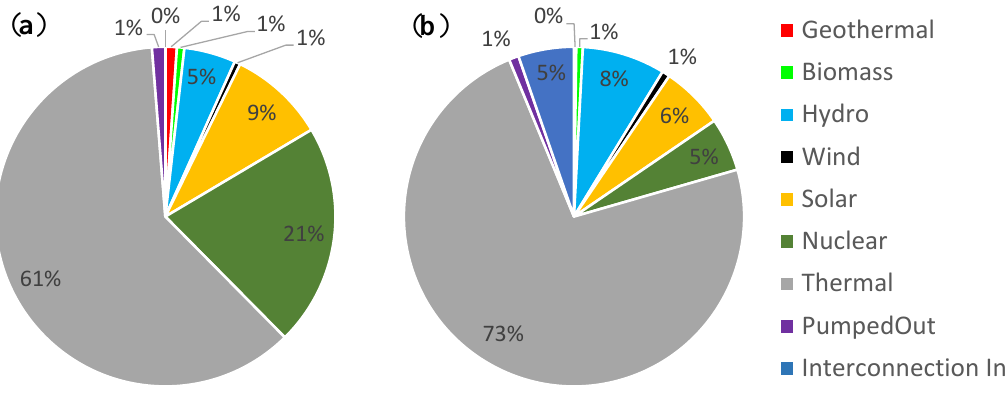
Figure 5. ( a ) Electricity generated in Kyushu in 2018 and ( b ) electricity generated in Japan in 2018. The hourly sum of the supplies should always equal the demand as described in Equation (1).